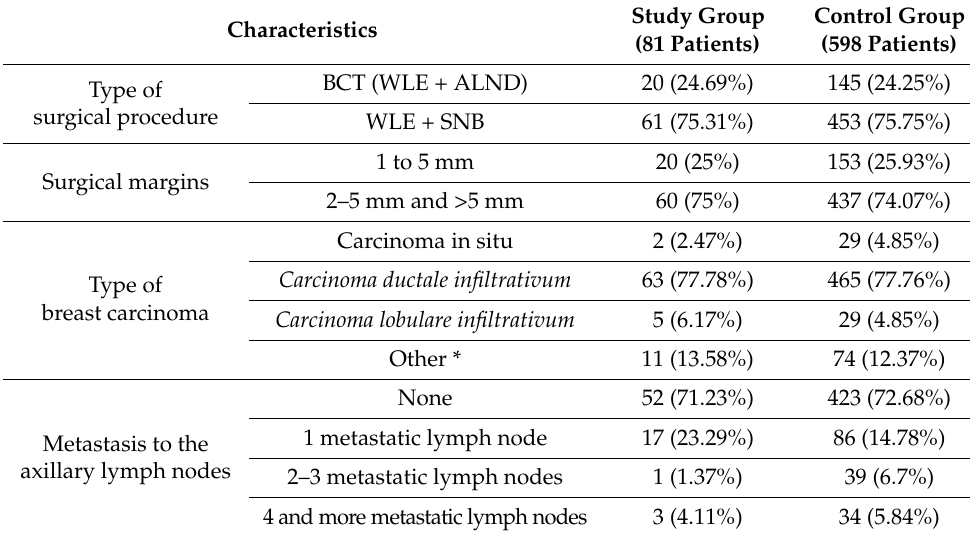
Figure 1. Characteristics of breast cancer patients who underwent oncoplastic surgery. Table 1. Characteristics of the study and control